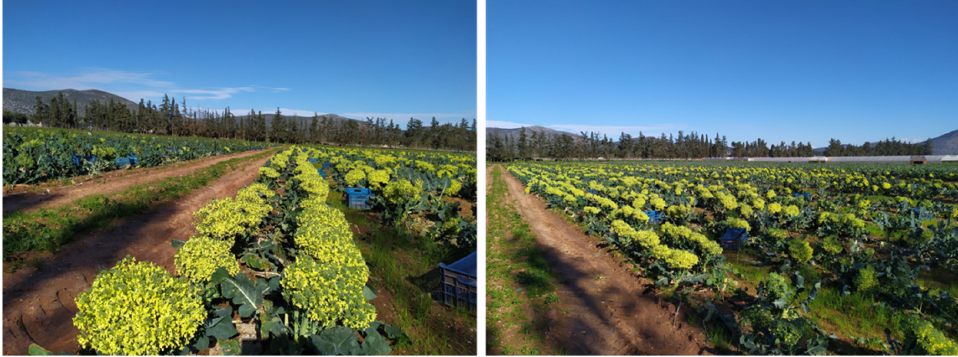
Figure 1. Examples of broccoli fields in full bloom, representing yield losses due to quality degra- dation.